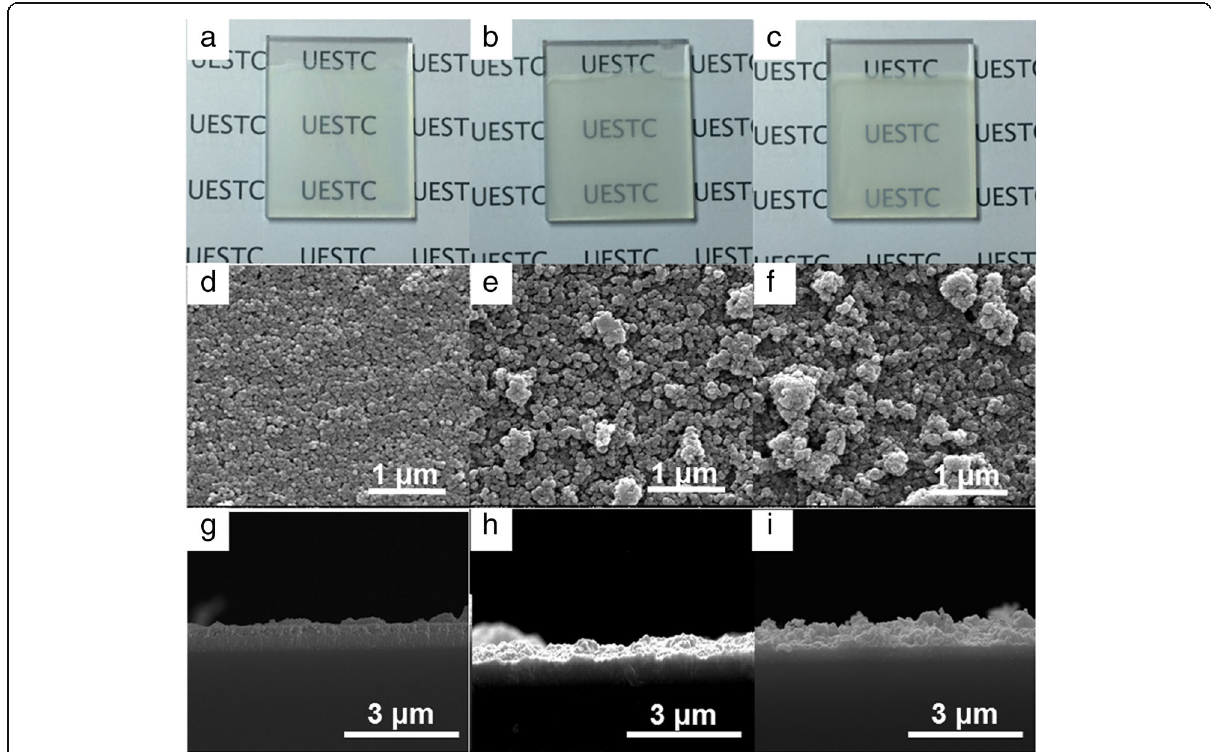
Fig. 2 (Color online) Photographs of TiO 2 thin films prepared with nanoparticle sizes of a 5~10, b 40, and c 100 nm, respectively. In-plane SEM images of TiO 2 thin films prepared with nanoparticle sizes of d 5~10, e 40, and f 100 nm, respectively. Cross-sectional SEM images of TiO 2 thin films prepared with nanoparticle sizes of g 5~10, h 40, and i 100 nm,